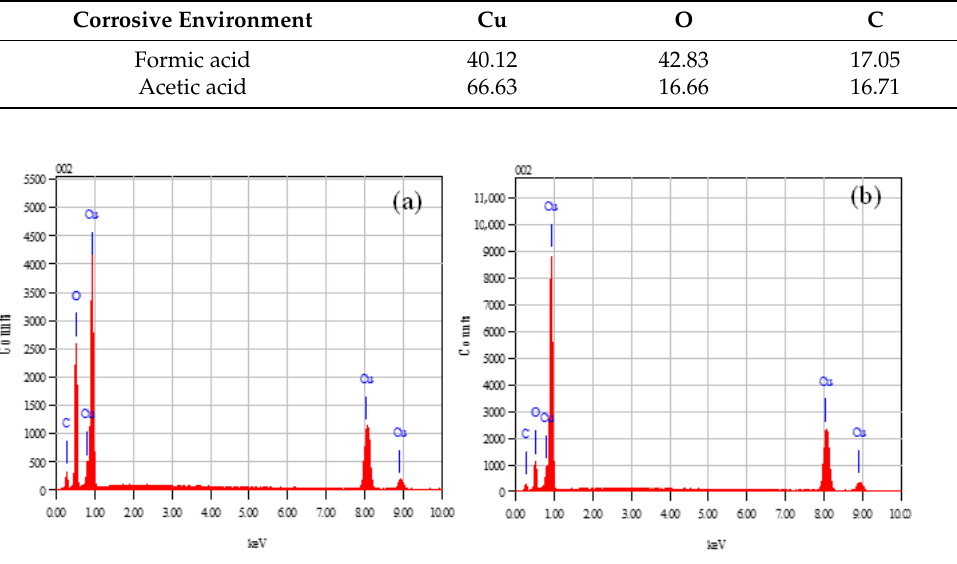
Figure 11. X-ray diffraction of copper sample in organic acid environment: ( a ) Formic acid; ( b ) Ace- tic acid; a = Cu; b = Cu 2 O; c = Cu(OH) 2 ; d = CuO; e = Cu(OH)(HCOO); f= Cu(HCOO) 2 ; g= Cu 2 (OH) 2 CO 3 ; h = Cu(CH 3 OO) 2 ·2H 2 O; i = Cu 4 OH(CH 3 OO) 7 ·2H 2 O.